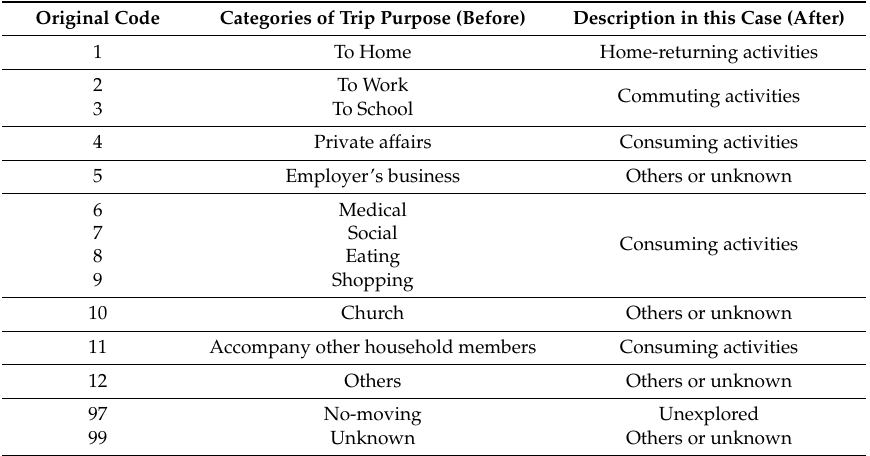
Table 2. Descriptions of trip purpose code. (cf. document from CSIS).